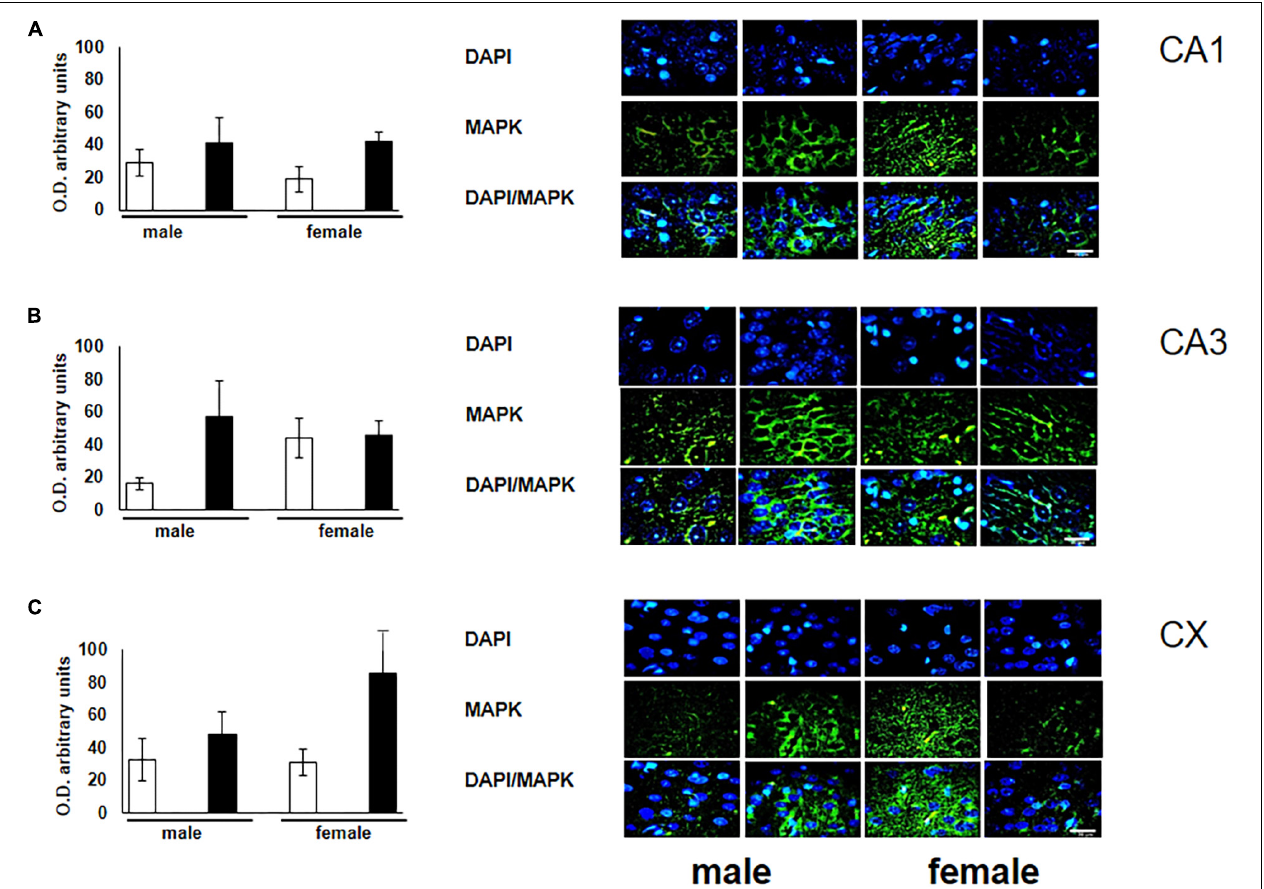
FIGURE 3 | Representative microphotography (objective 60 × and zoom 1.6 × ) showing immunopositivity for the MAPK (green) and DAPI-stained nuclei (blue). The graph indicates optical density arbitrary units for control group (white bars) and ozone group (black bars) in male and females, (A) CA1, (B) CA3 and (C) CX. We observed a non-significant increase in the expression of MAPK in CA1, CA3, and CX. Bars indicate the mean ± SEM, using univariate comparison statistics. ∗ P ≤ 0.05. Scale bar = 20 µ